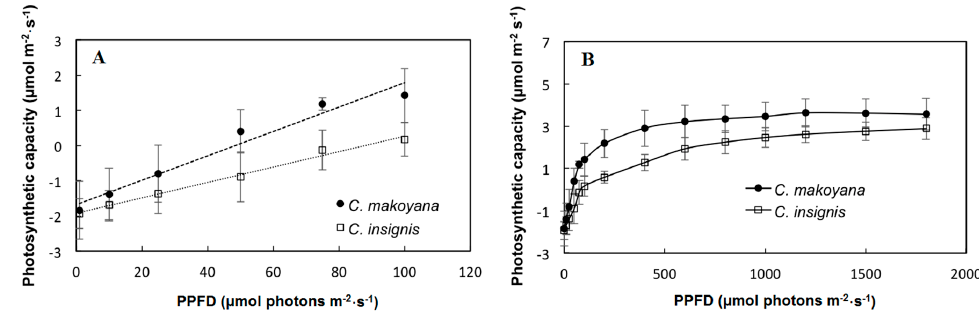
Figure 1. Photosynthetic capacity of Calathea makoyana and C. insignis under 0–100 ( A ) and 0–1800 ( B ) µ mol · m − 2 · s − 1 photosynthetic photon flux density (PPFD). Vertical bars indicate the standard deviation ( n = 5).